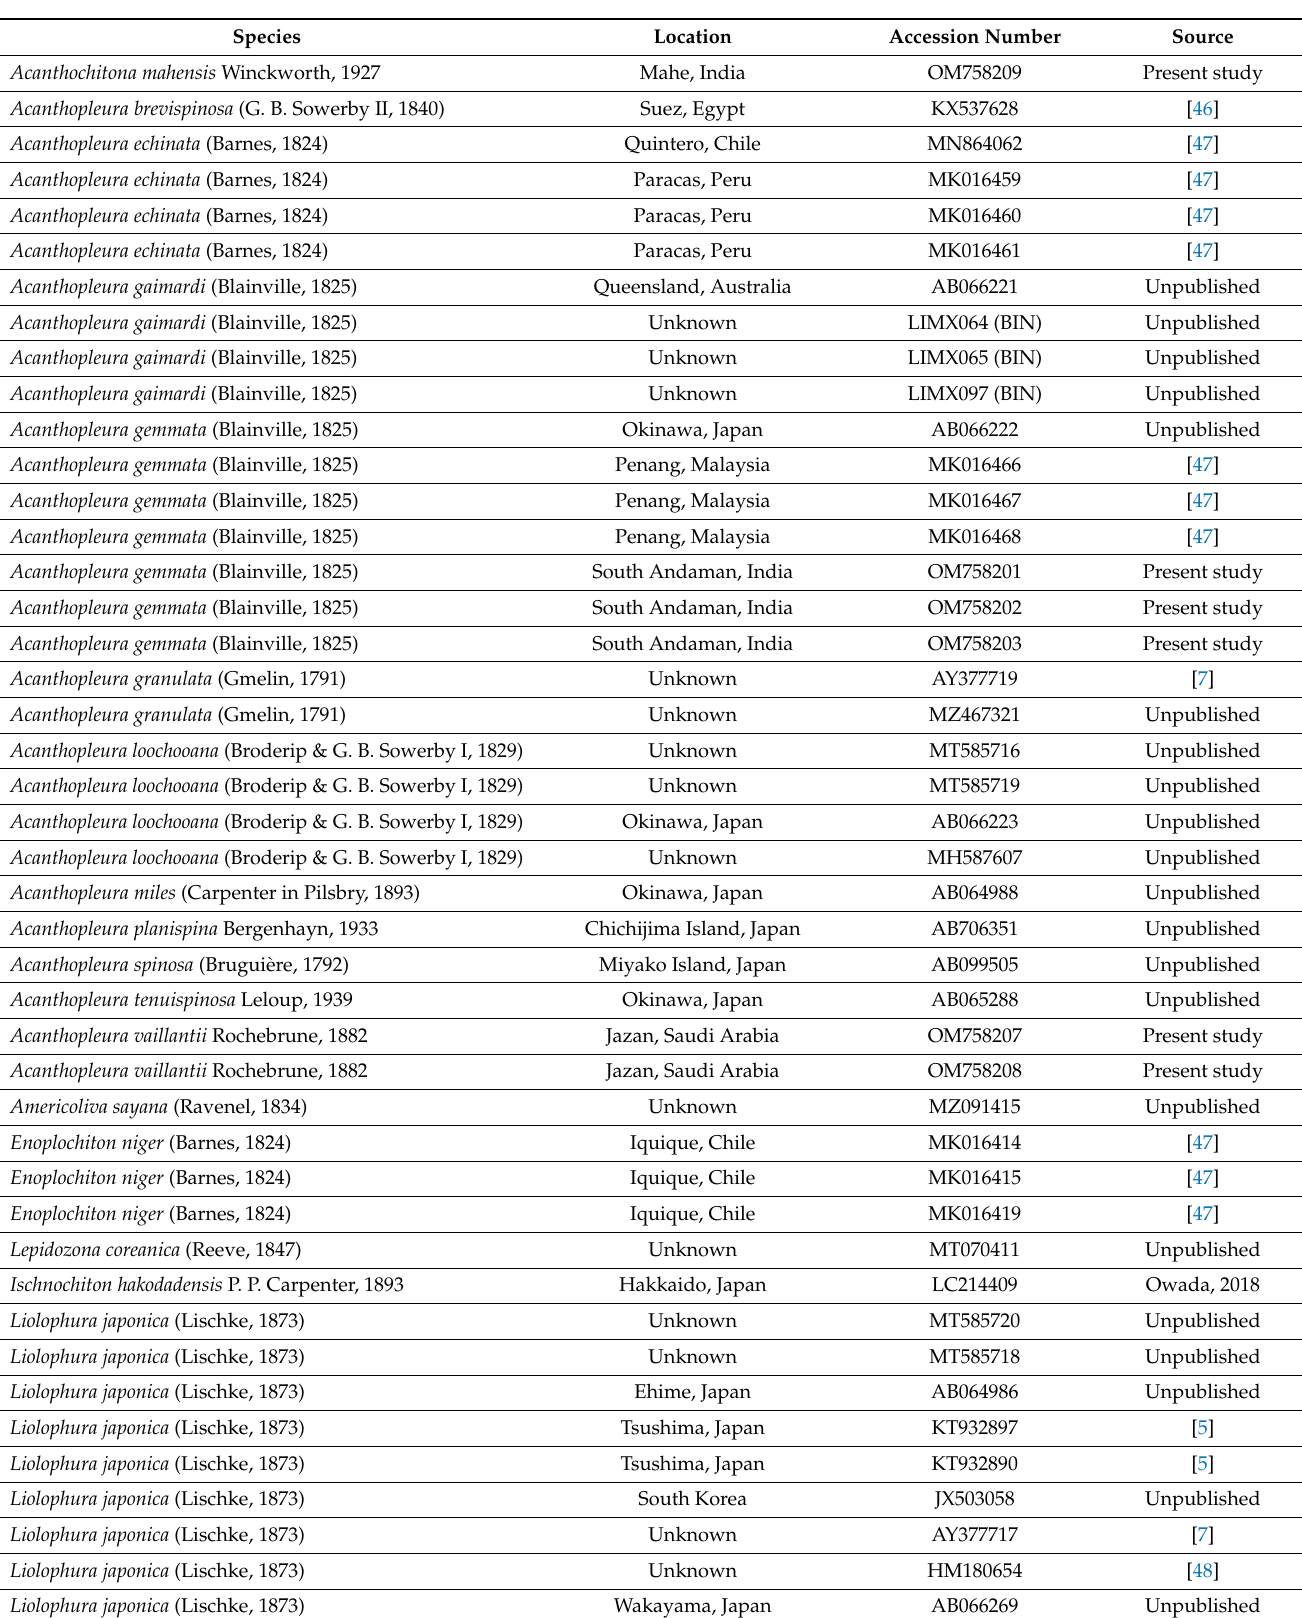
Table 3. Accession numbers and sources of sequences of COI used in the present study were retrieved from NCBI GenBank. Sequences retrieved from the BOLD database are mentioned as